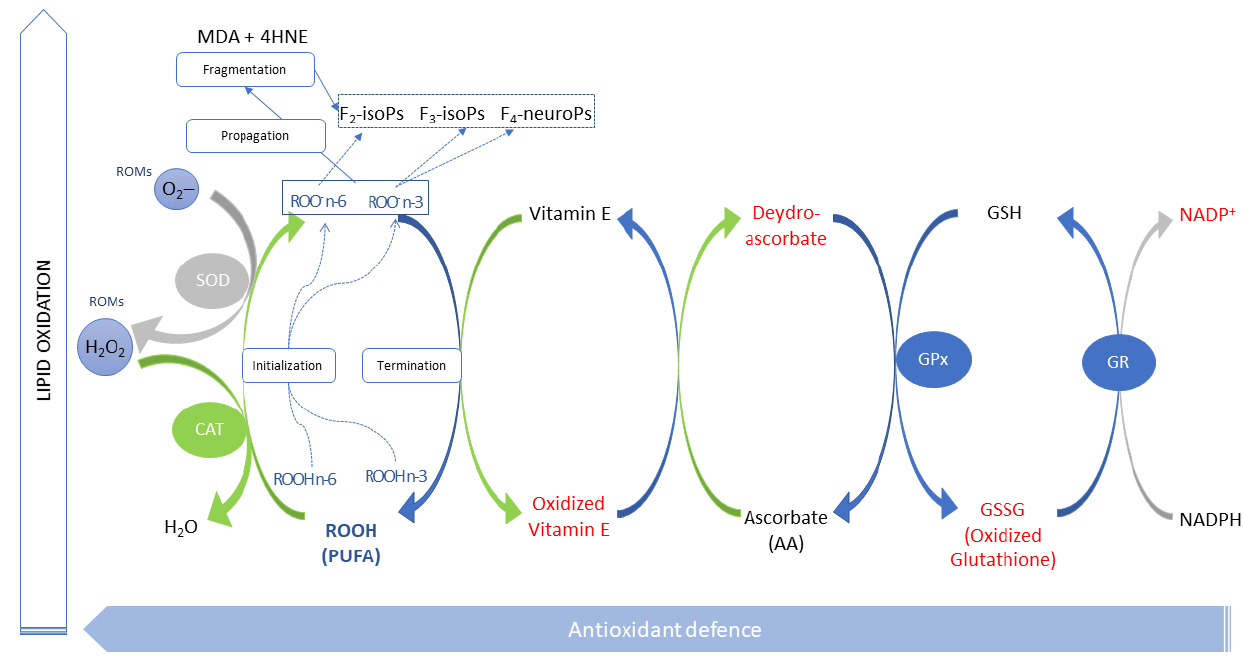
Figure 9. The main steps of the polyunsaturated fatty acid (PUFA) oxidative chain and antioxidant interactions. The red colour indicates oxidised molecules. MDA, malondialdehyde; 4HNE, 4-hydroxynonenal; GSH, glutathione; GPX, glutathione peroxidase, GR, glutathione reductase; F 2-, 3 -isoPs, F 2- , 3 -isoprostanes; F 4 -NeuroPs, F 4 -neuroprostanes; SOD: superoxide dismutase; CAT: catalase: ROMs: reactive oxygen